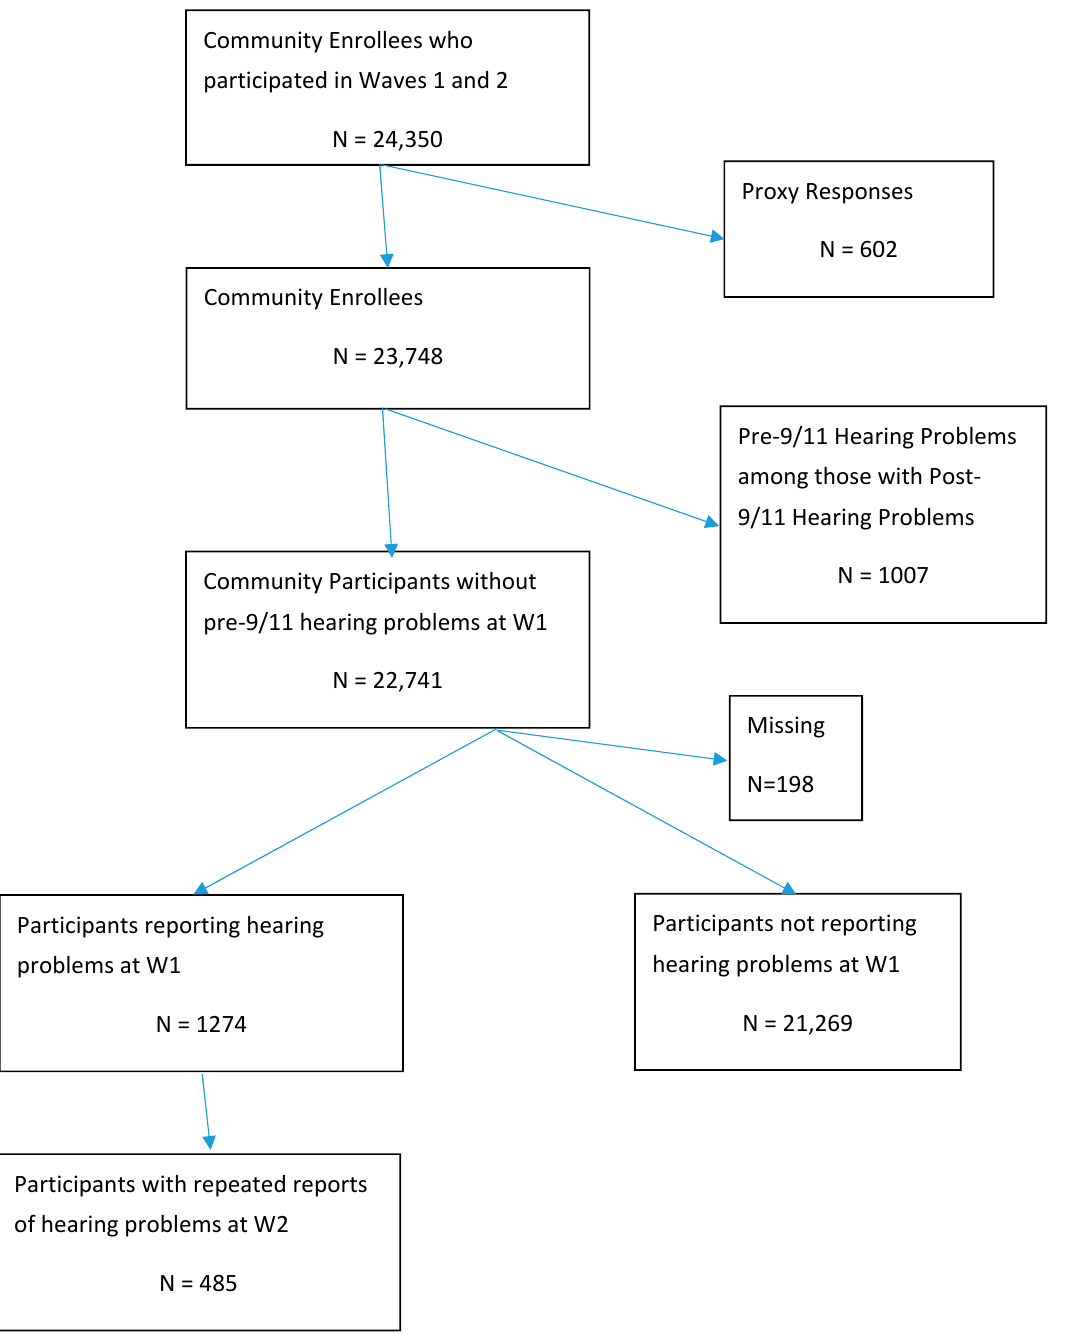
Figure 1. Flow chart of participation.